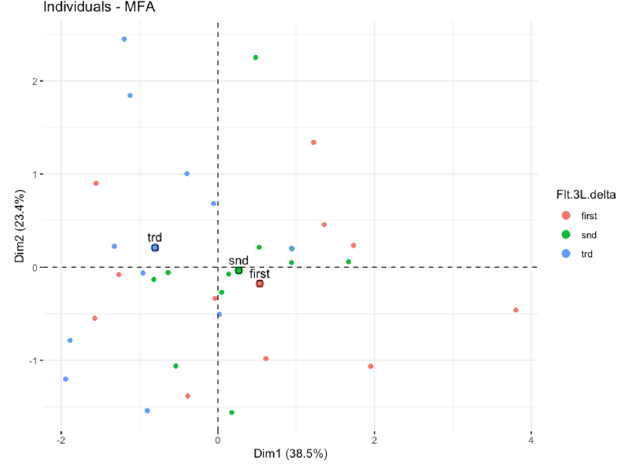
Figure 4. Individual factor map showing data distribution. According to early change of Flt-3L (Flt-3L delta).